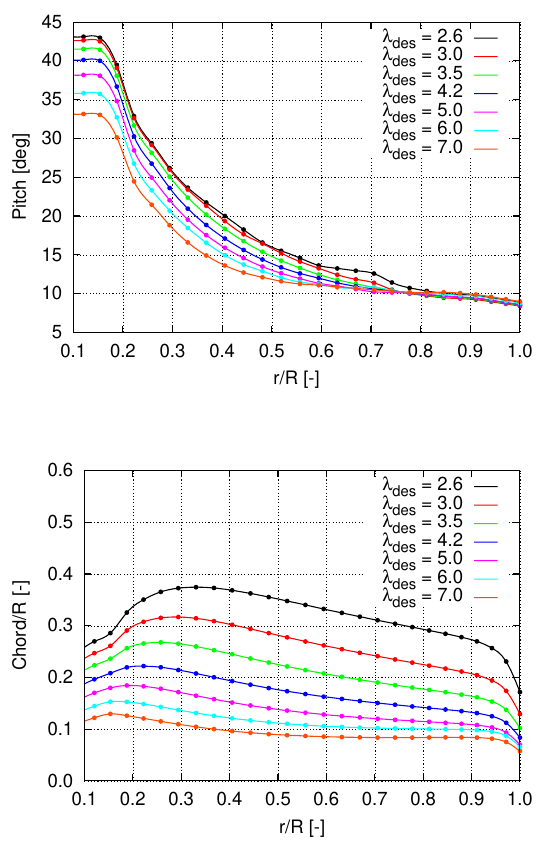
Fig. 19. Model turbine: radial distributions of pitch β (top) and non- dimensional chord c/R (bottom) for λ des values from 2.6 to 7.0.